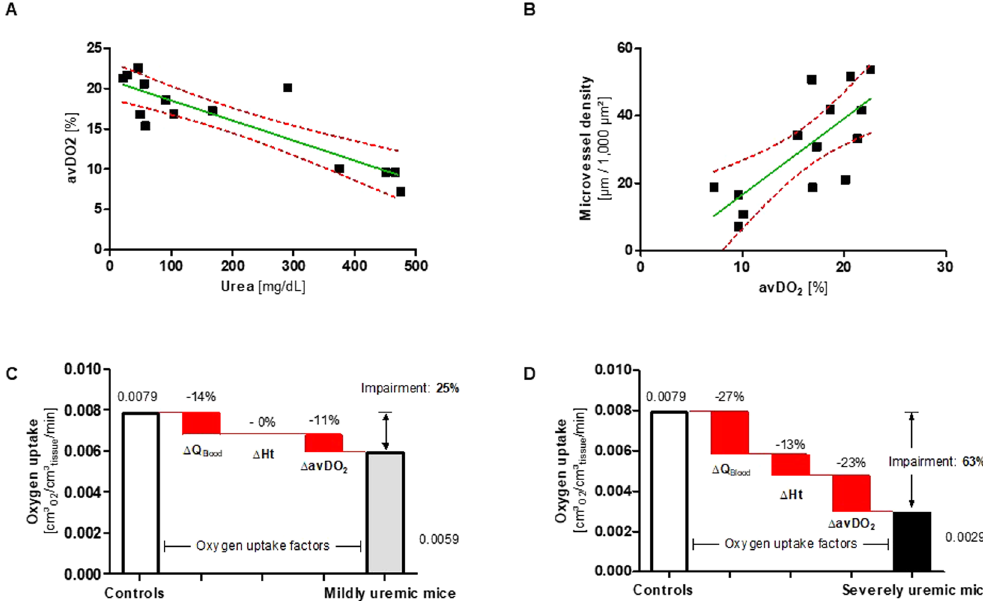
Figure 4. Oxygen uptake from the microcirculation is substantially impaired in CKD. ( A ) Arteriovenous difference in the oxygen saturation of hemoglobin (avDO 2 ) between arterial and venous microvessels of diameters 64 µ m to 128 µ m was measured in controls (n = 3), mice with mild uremia (n = 2), severe uremia (n = 5), sham operated mice (n = 3), and SNX (n = 1). AvDO 2 correlates negatively with serum urea (p < 0.0001; r = − 0.87). ( B ) Microvessel density positively correlates with avDO 2 (p = 0.0022; r = 0.75). ( C ) Oxygen uptake rate (O 2 transition from the microcirculation into the tissue) of controls (n = 8) compared to mildly uremic mice (n = 12). The oxygen uptake rate is impaired by 25%. Three factors contribute to the impairment (assuming additive effects): (1) reduced blood flow velocity ( Δ V Blood ), (2) decreased hematocrit ( Δ Ht), (3) minor avDO 2 ( Δ avDO 2 ). ( D ) Oxygen uptake rate of controls (n = 8) compared to severely uremic mice (n = 7), the oxygen uptake rate is impaired by 63%. Assuming additive effects, the percentage contributions of Δ VBlood, Δ Ht and Δ avDO 2 were calculated in a mass balance model based on measurements in the 64– 128 µ m caliber vessels (red bars) for mildly uremic ( C ) and severely uremic mice ( D